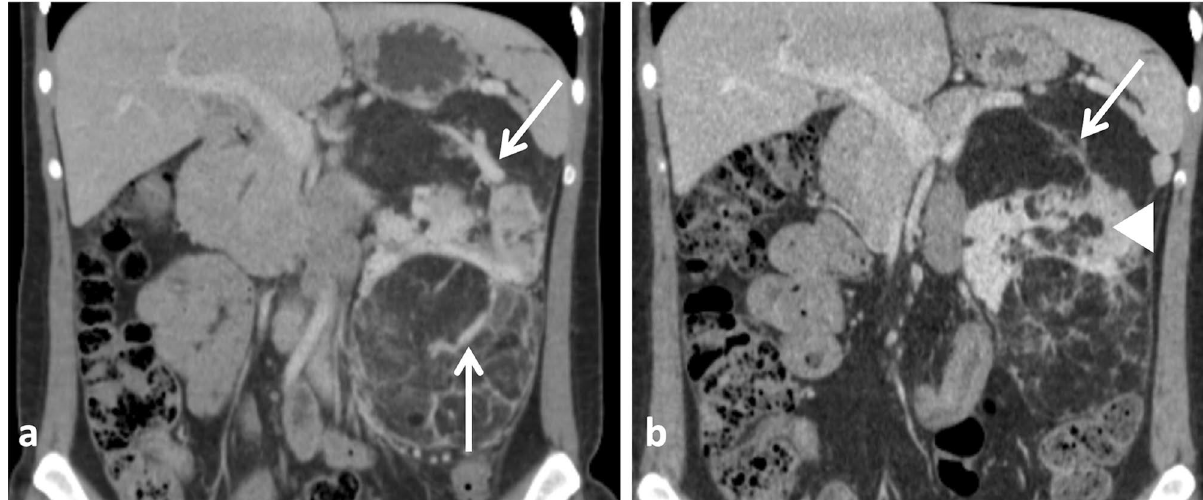
Figure 5. Response of intralesional vascular structures to sirolimus. Coronal nephrographic-phase CT images obtained ( a ) before the treatment and ( b ) after the treatment show disappearance of a left kidney large intralesional vascular structure and remarkable reduction of an intralesional aneurysm in response to treatment with sirolimus (arrows). An increase in the fat component is also seen (arrowhead).